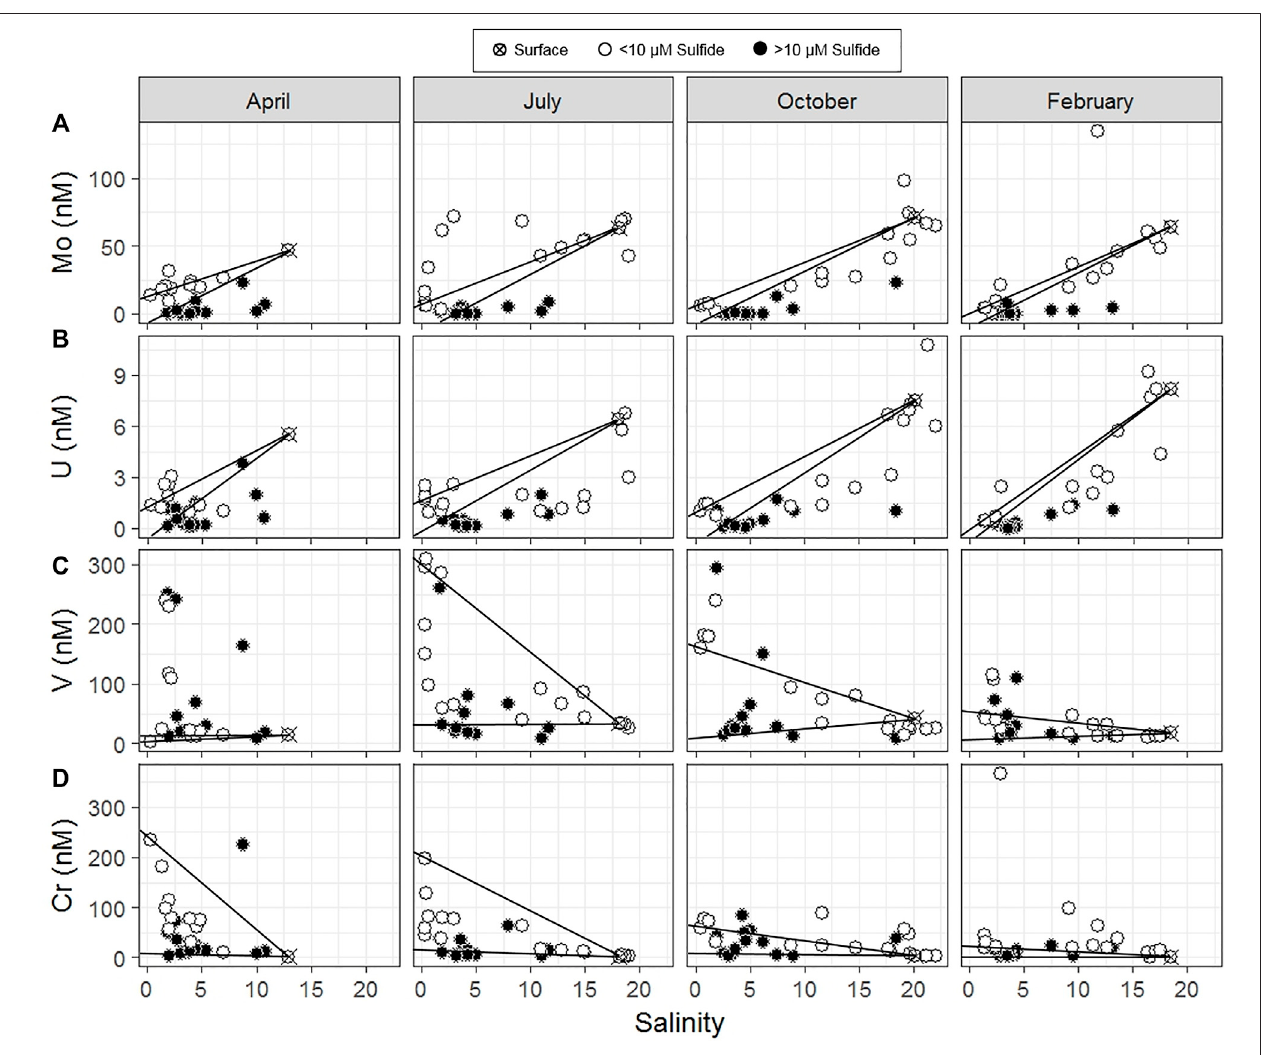
FIGURE 4 | Salinity mixing diagrams of dissolved (A) Mo, (B) U, (C) V, and (D) Cr. Solid symbols indicate samples in which sul fi de concentrations exceed 10 µM. Conservative mixing lines are drawn between the saline surface water endmember and both the deep and shallow freshwater endmembers ( Table 1 ). Samples falling above and below the conservative mixing lines suggest non-conservative addition and removal,